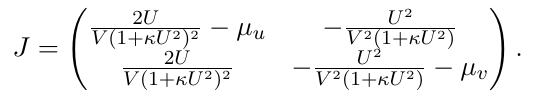
Fig. 2. Solution curves in ( y, z ) -space associated to potential energies U 1 and U 0 .